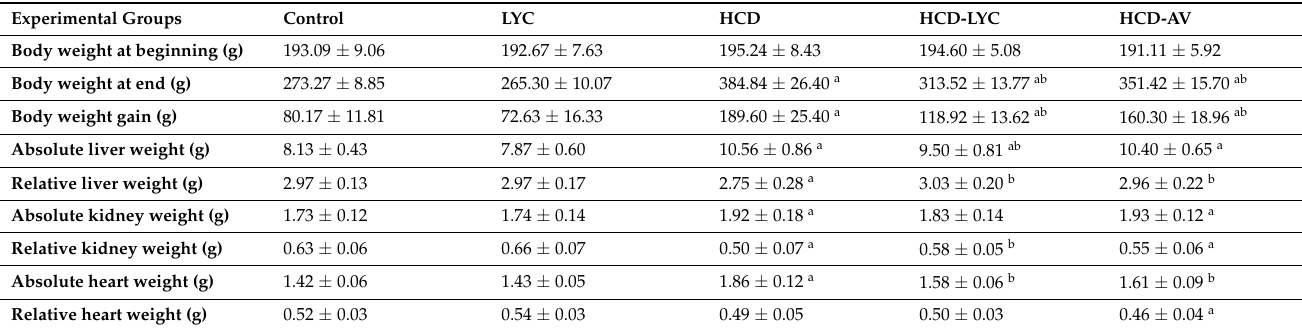
Table 1. Effects of dietary cholesterol and lycopene on body weight and organ weight (absolute and relative) in rats over 12 weeks.